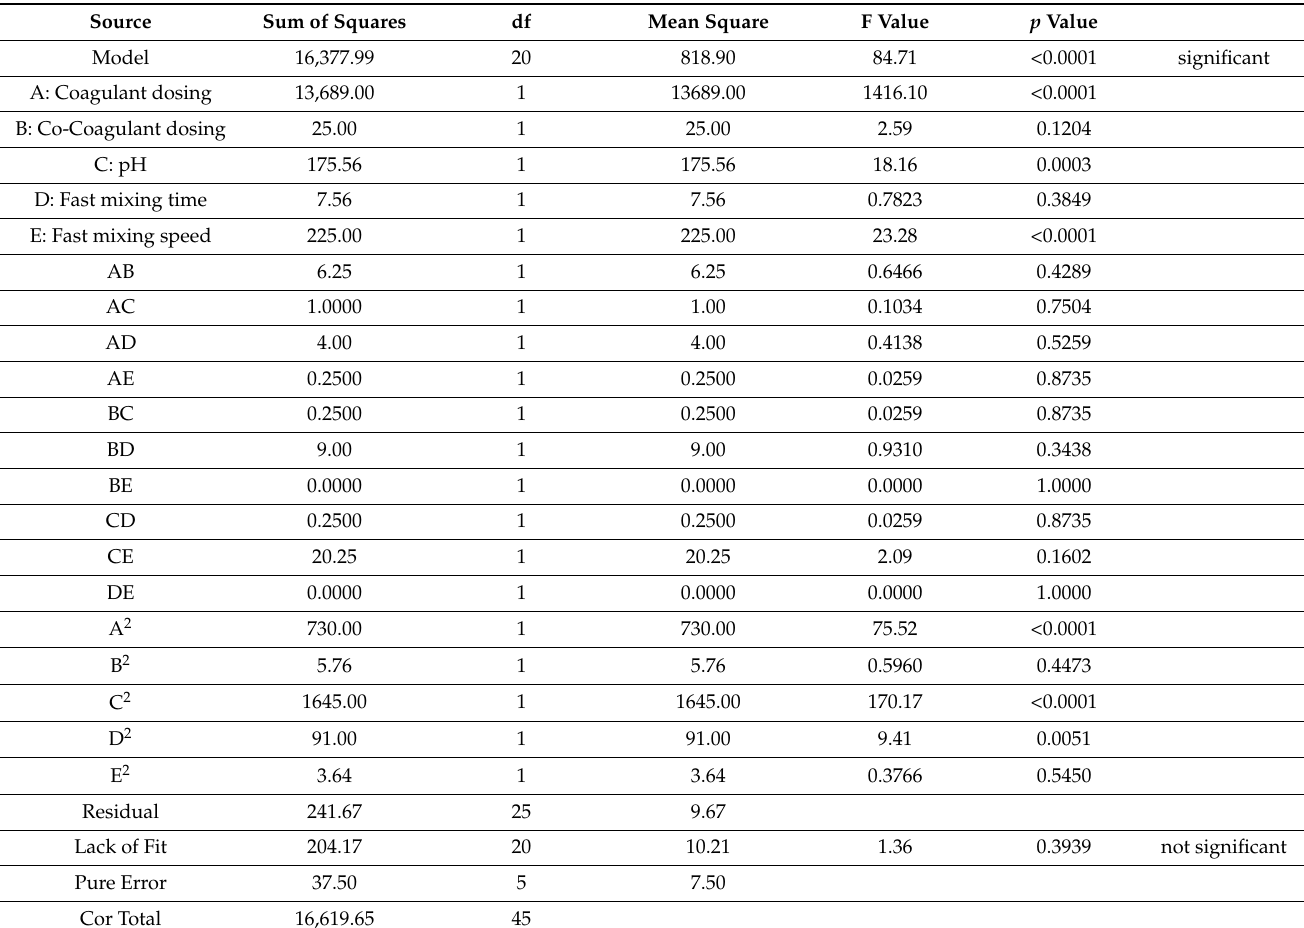
Table 1. Analysis of variance of response surface quadratic model for As(V) removal via the coagulation-flocculation